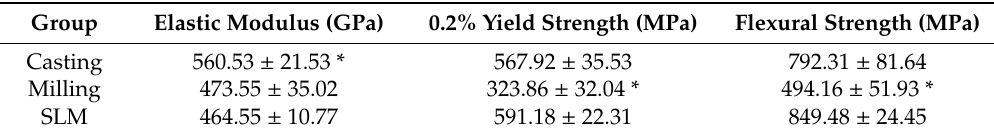
Table 3. Mechanical properties of the specimens.